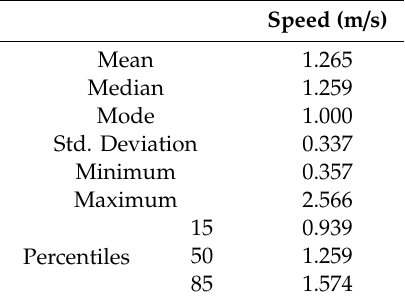
Table 2. Descriptive statistics of pedestrian crossing